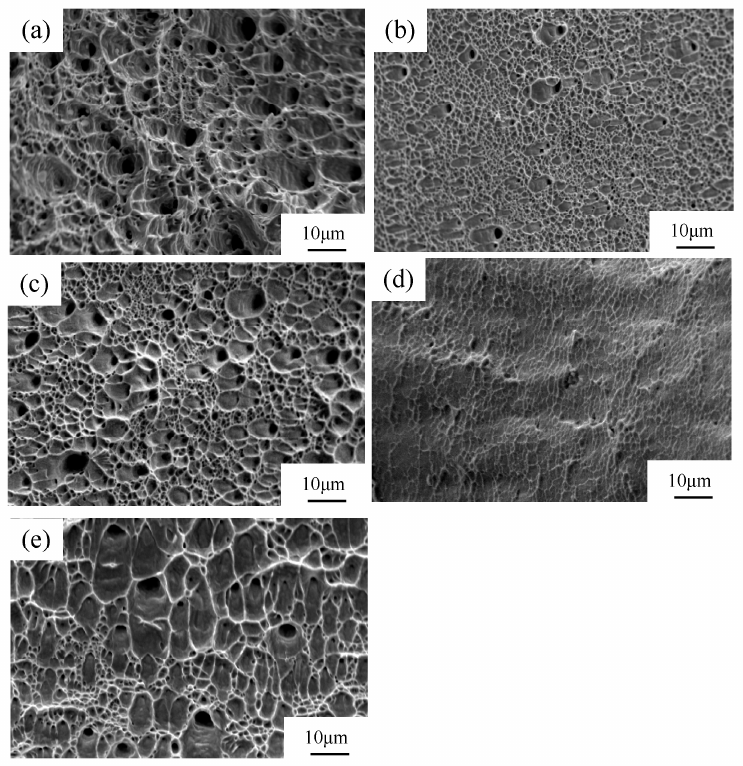
Figure 6. Fracture surface morphology of the 316LN austenitic stainless steel before and after rolling: ( a ) original austenite structure; ( b ) CR-30%; ( c ) RTR-30%; ( d ) CR-90%; and ( e ) RTR-90%.